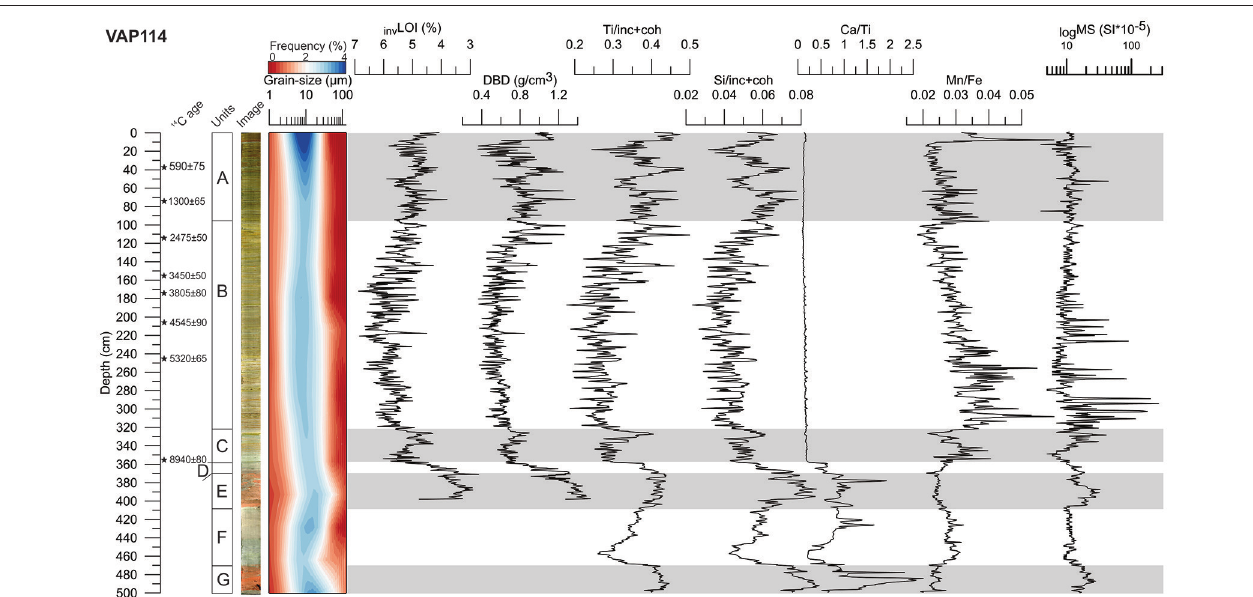
FIGURE 7 | Selected magnetic, physical, and geochemical properties of VAP114. From left to right: 14 C-ages ± 1 σ from selected intervals; core image of VAP114; units (A–F) found in VAP114 based on lithostratigraphy; grain size frequency presented as surface plot (Beierle et al., 2002); loss-on-ignition (LOI); dry bulk density (DBD); ratio between titanium and the sum of incoherent and coherent scattering (Ti/inc + coh); ratio between silica and the sum of incoherent and coherent scattering (Si/inc + coh); ratio between calcium (Ca) and titanium (Ti); ratio between manganese (Mn) and iron (Fe); magnetic susceptibility (MS).